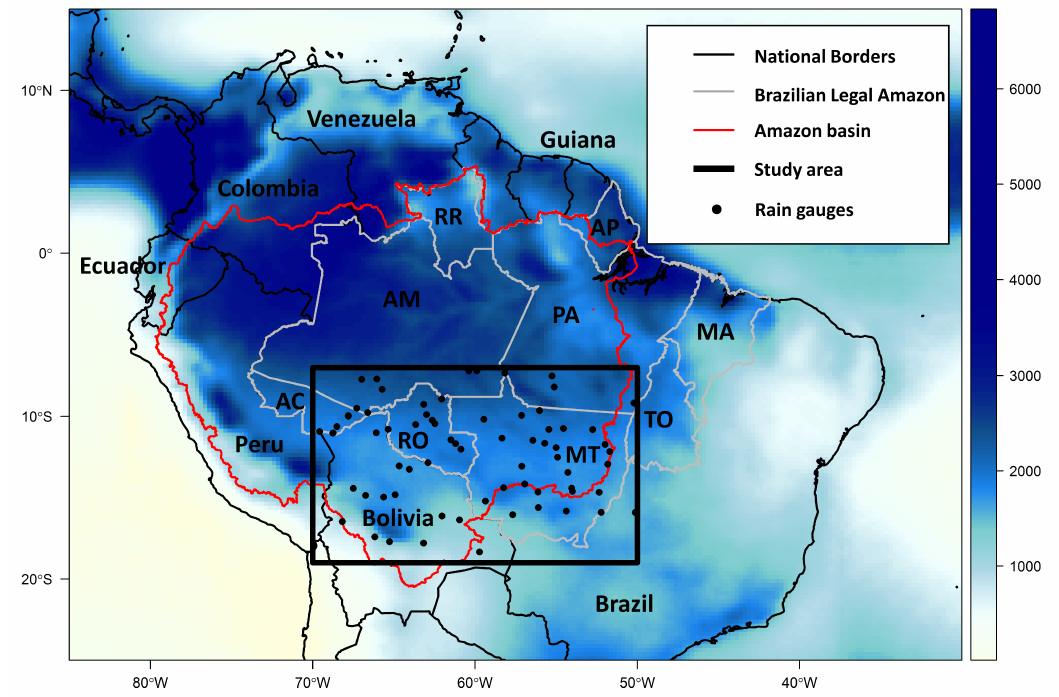
Figure 1. Mean annual rainfall (1983–2014, computed per calendar year) in the Amazon measured using the Precipitation Estimation from Remotely Sensed Information using Artificial Neural Networks—Climate Data Record (PERSIANN-CDR) data with location of the study area